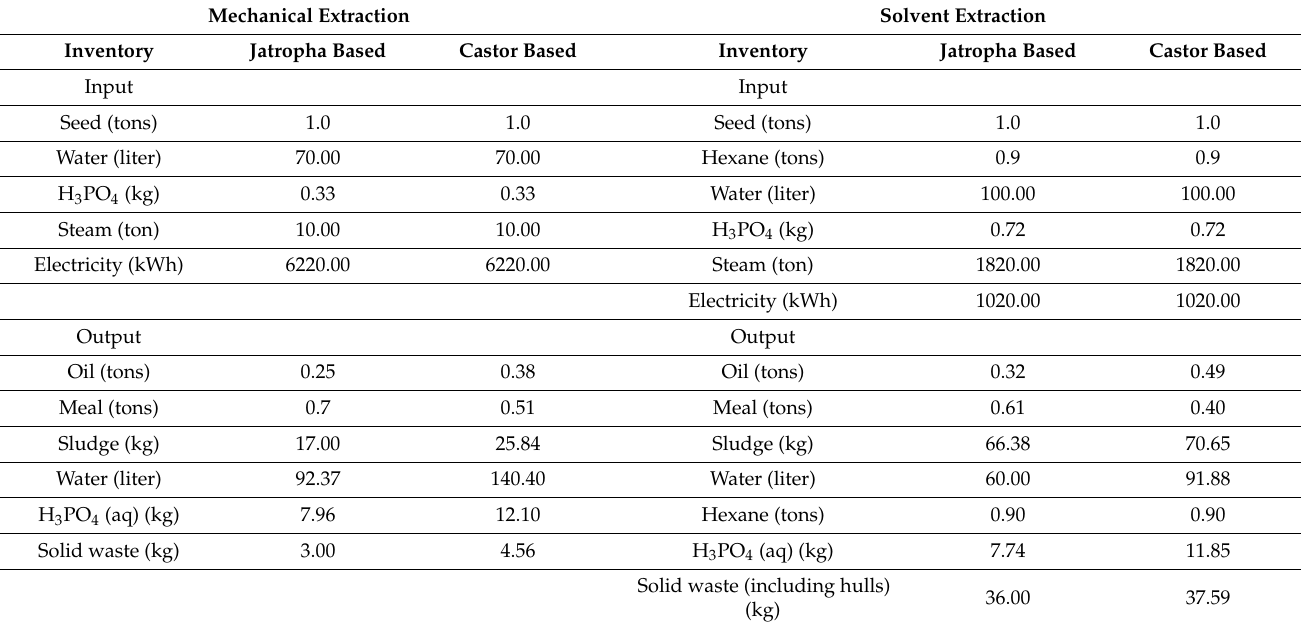
Table 2. Material and energy inputs and outputs in mechanical and solvent extraction of jatropha and castor seed.